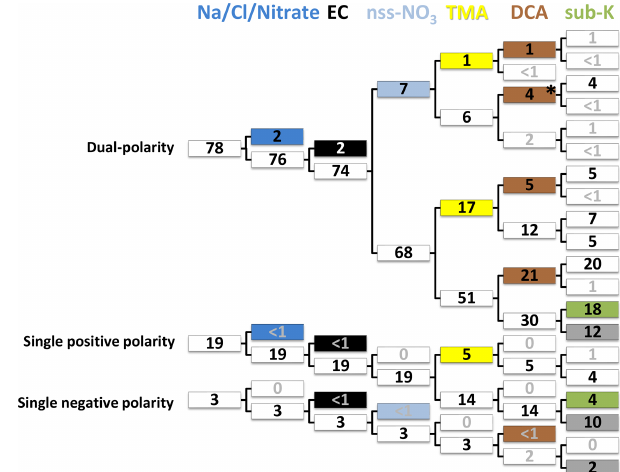
Figure 4. Classification of 10137 single-particle spectra based on the ion marker method and illustrated with the decision tree (see Sect. 2.4). Upper and lower branches refer to the presence and ab- sence of substances in the particle mass spectra, respectively. Num- bers are given as relative abundances in % normalized to 10137 particles. The initial classification provides three groups of particle mass spectra with dual, single positive, and single negative polar- ity. Particle types, indicated by colours, contain Na/Cl/Nitrate (dark blue), EC (black), non-sea-spray (nss)-NO 3 (light blue), trimethy- lamine (TMA) (yellow), dicarboxylic acids (DCA) (brown), potas- sium (sub-K) (green), and “remaining” (gray filling). As an exam- ple, 4% of 10137 particles (indicated by the asterisk) contain DCA and nss-nitrate (from right to left). The remaining particles are fur- ther sub-classified in Fig.